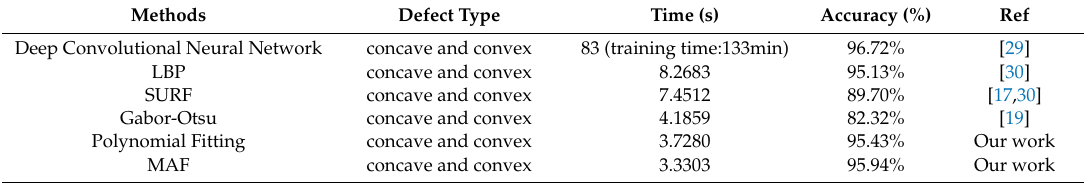
Table 2. Accuracy rates and detection time with di ff erent